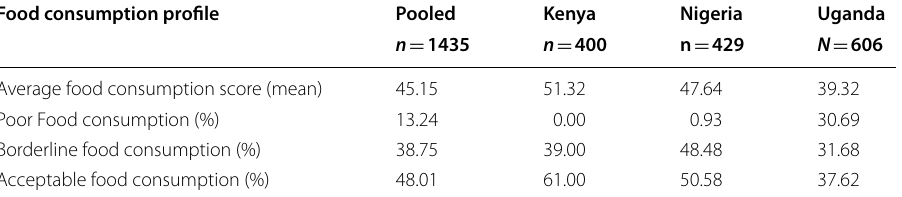
Table 3 Category of food consumption score by country